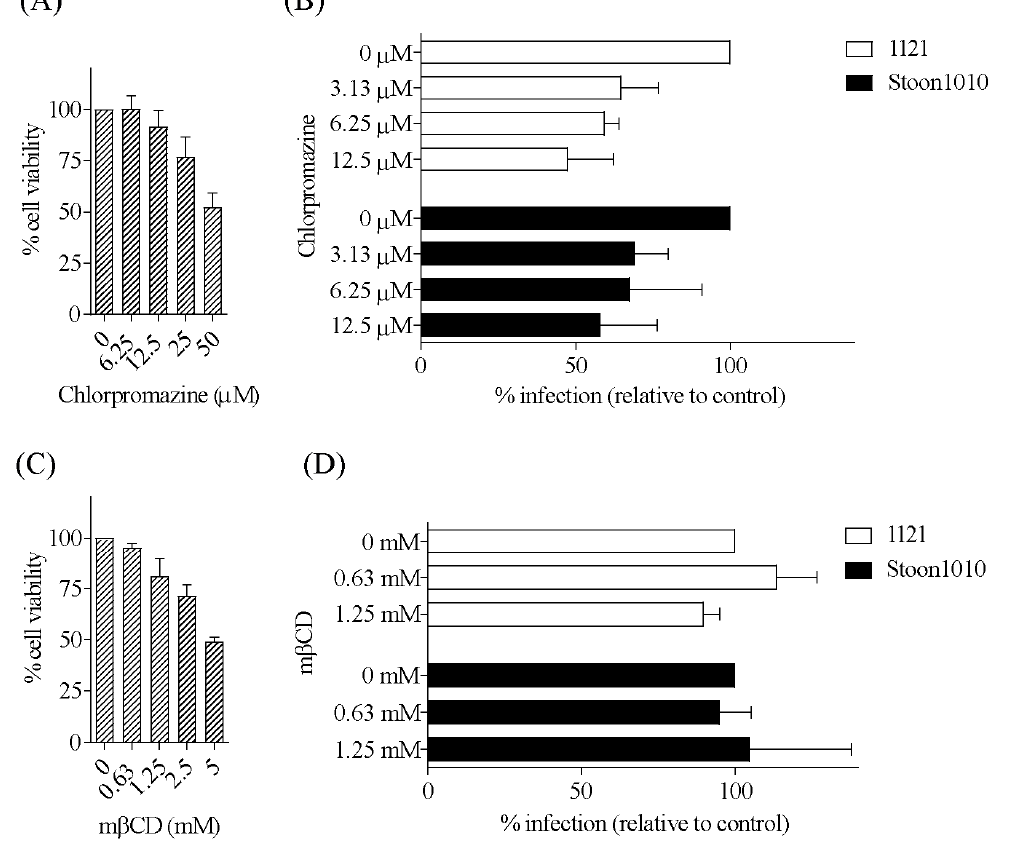
Figure 9. PCV2 entry into T-lymphoblasts is via clathrin-mediated endocytosis, and is independent of caveolae-mediated endocytosis. ( A , C ) Viability of cells treated with di ff erent concentrations of chlorpromazine ( A ) or m β CD ( C ), as measured by MTT assay. ( B , D ) Cells were pre-treated with chlorpromazine (0, 3.13, 6.25, 12.5 µ M) ( B ) or with m β CD (0, 0.63, 1.25 mM) ( D ) prior to PCV2 infection. The percentage of PCV2-infected cells was quantified. The infection level in the treated group was expressed as the relative percentage to that of the control group (drug concentration = 0 µ M). Data represent means ± SD of triplicate